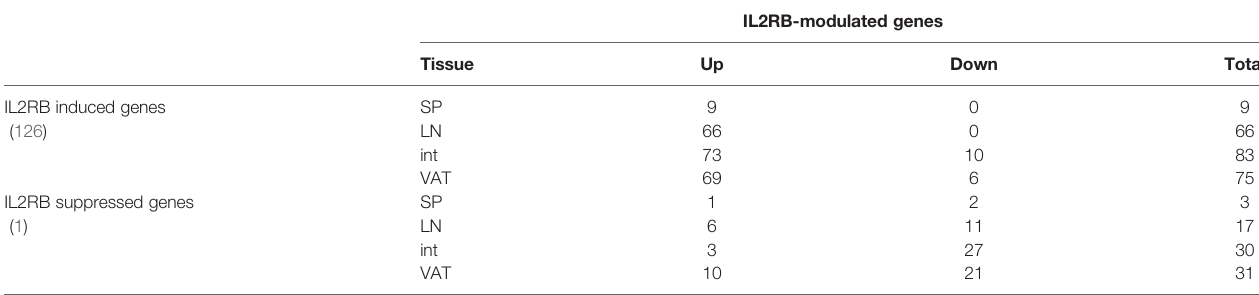
TABLE 8C | In order to investigate the modulation of IL2RB in Treg from different tissues, we identi fi ed the expression change of IL2RB induced genes in four tissues we